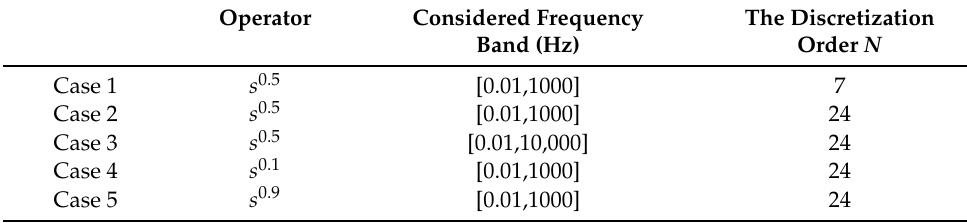
Table 1. Parameters of discretization